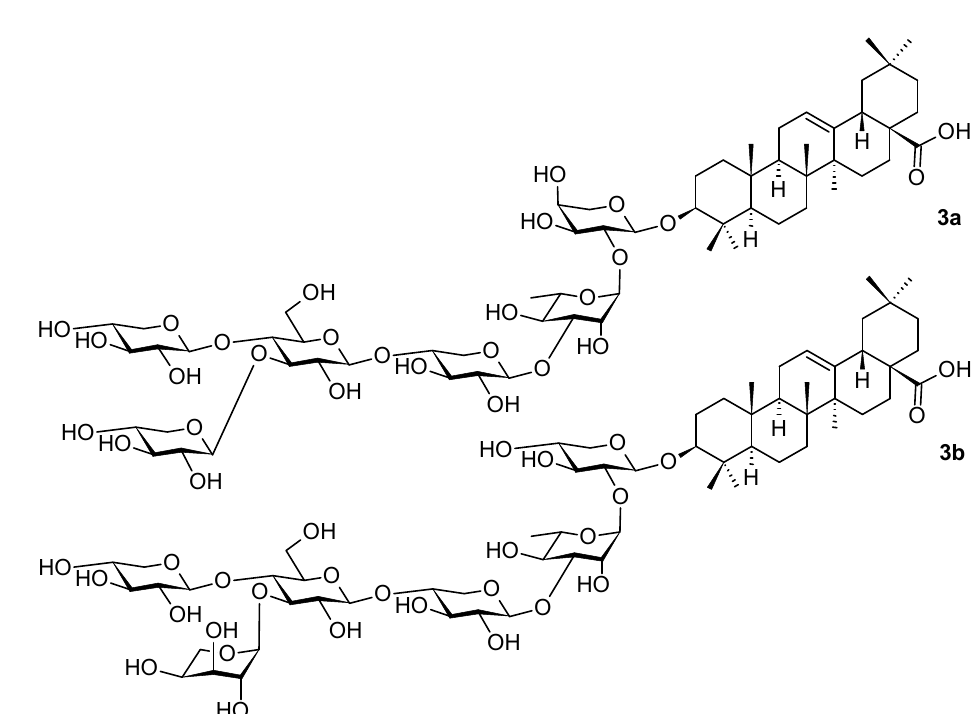
Figure 3. Oleanane-type triterpenoids found in the plants of the genus Weigela (part 1). Weigela species were also studied by other authors [45], who isolated additional oleanane-type saponins ( 4a – 4d ; Figure 4 and 5a – 5f ; Figure 5) from three Weigela (Thunb.) hybrids and cultivars: W. x Styriaca , W. florida “Minor black”, and W. florida “Brigela” [45]. The authors elucidated the structures of all new compounds of the series of 4a – 4d (Figure 4) and 5a – 5f (Figure 5) [45]. The tested saponins 4a – 4d and 5a – 5f showed antifungal ac- tivity ( Candida albicans ) and antibacterial activity ( Staphylococcus aureus , Pseudomonas aeru- ginosa ) with the minimum inhibitory concentrations MIC ~200 µg · mL − 1 [45].